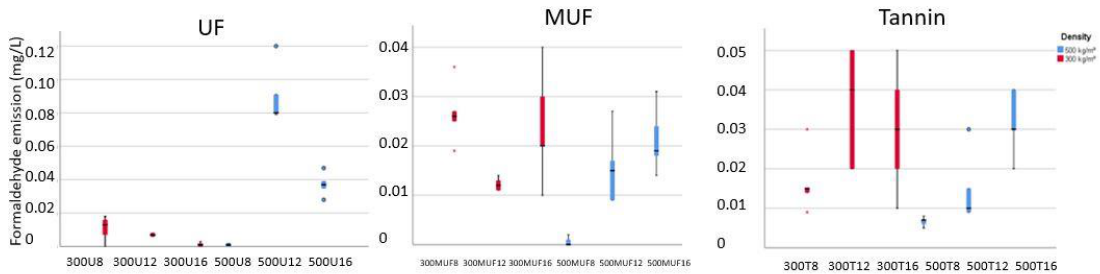
Figure 2. Formaldehyde emission (mg/L) of the larch bark-based insulation boards 300 and 500 kg/m 3 bonded with UF, MUF, and tannin-based adhesives.